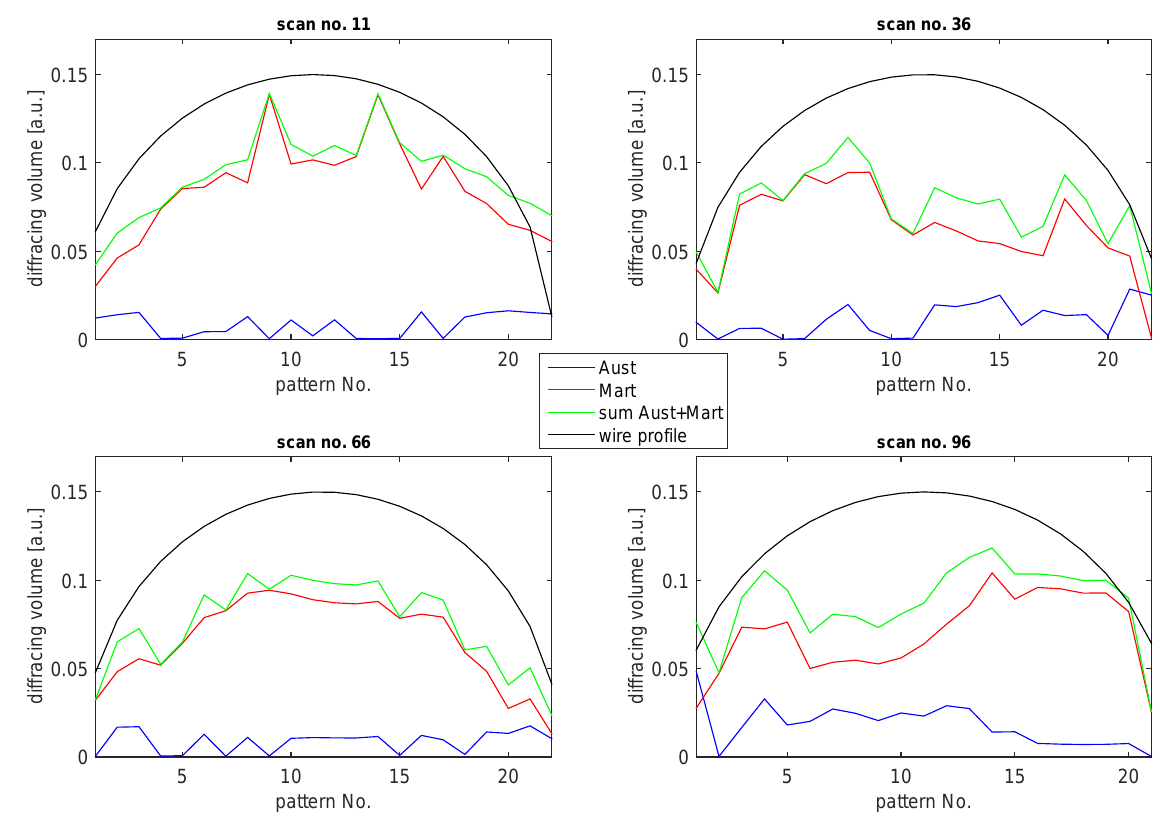
Figure 6. Results of phase analysis for four scans (no-texture approximation). The y axis shows diffracting volumes, x shows the order number of the images in the given scan. Blue color stands for the diffracting volume of austenite, the red one for the diffracting volume of martensite and the green one is a summation of the two. The black line indicates the theoretical wire mass profile.